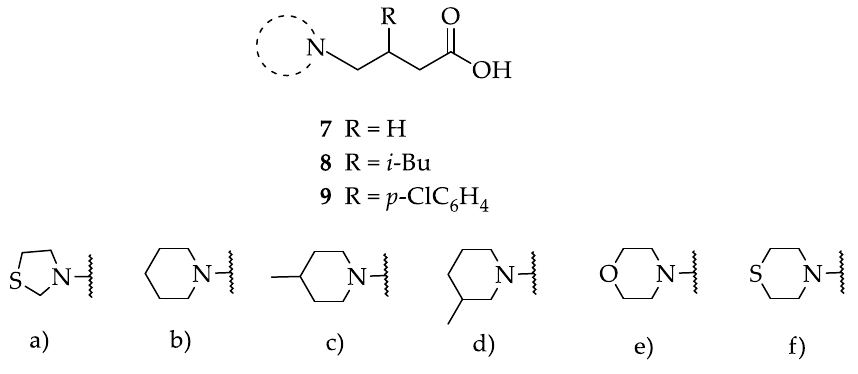
Figure 2. Structures of GABA analogues 7 , 8 and 9 .